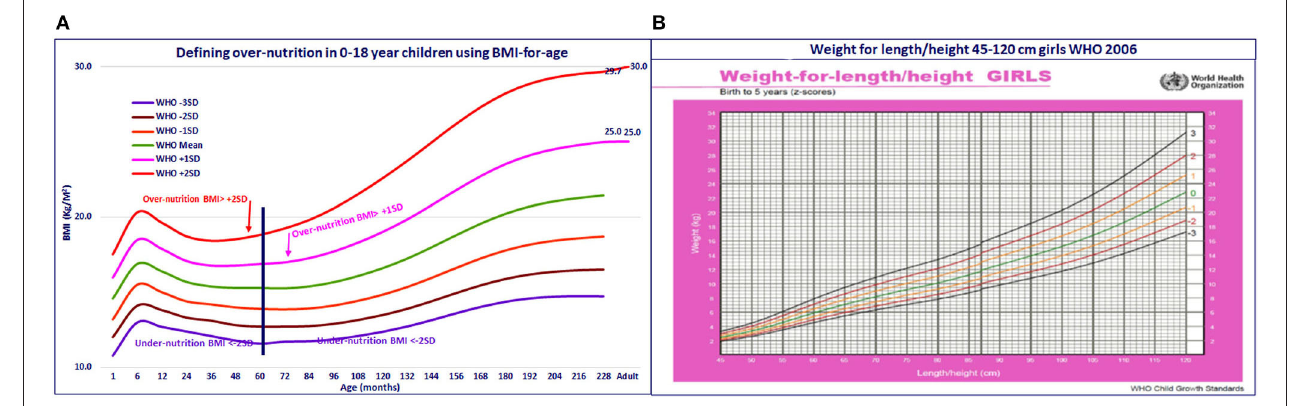
FIGURE 3 | (A) Defining over-nutrition in 0–18 year children using BMI-for-age. (B) Weight for length/height 45–120cm girls WHO